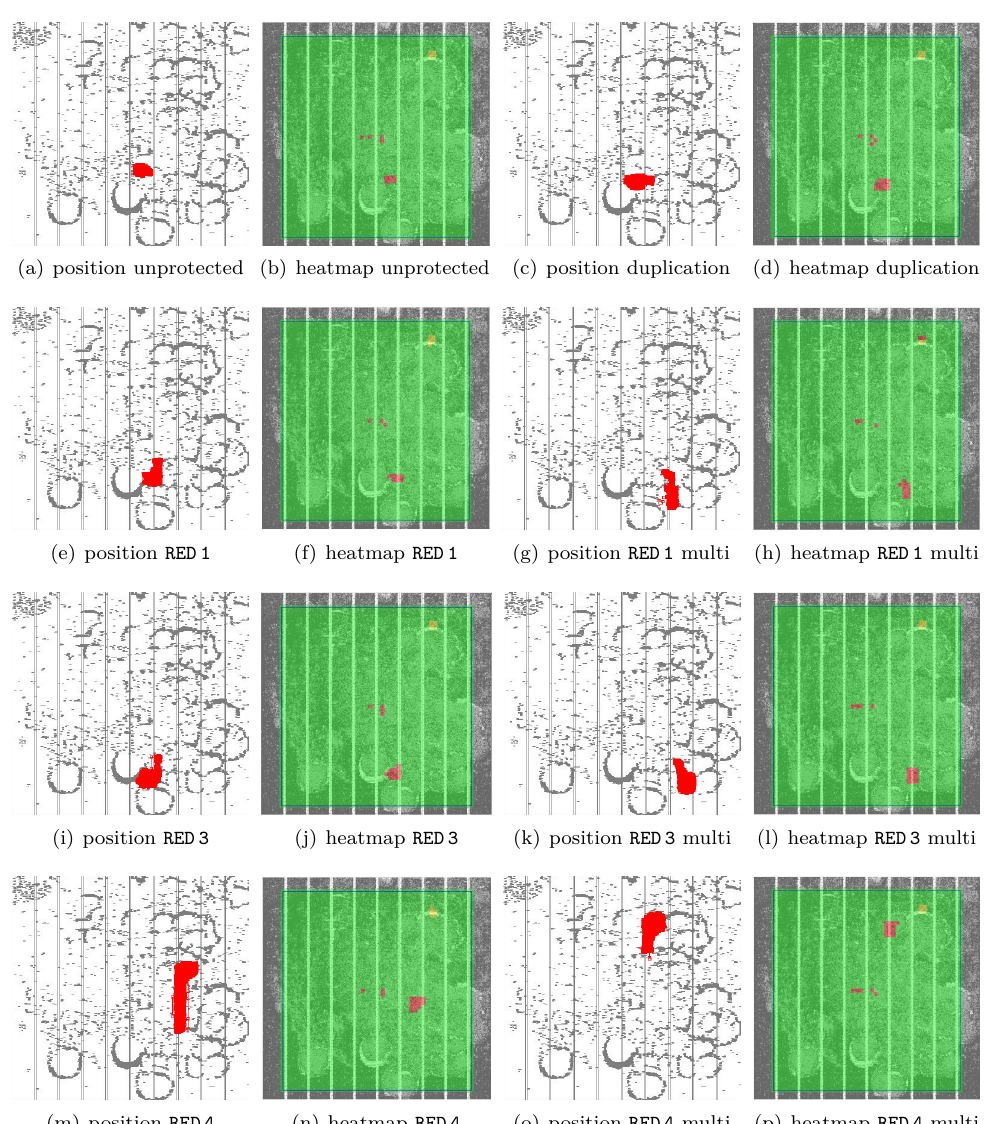
Figure 8: Positions of the individual SKINNY cores on the ASIC and heatmaps of the fault-sensitive areas generated from the initial coarse full-chip scan in each